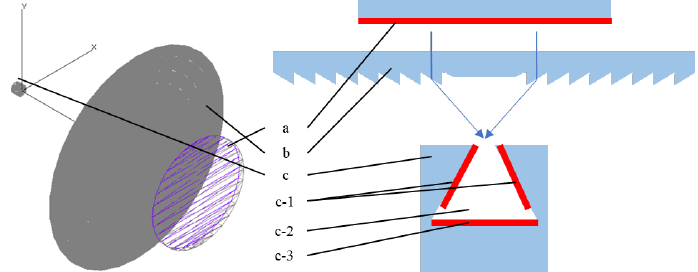
Figure 7. Ray-tracing scheme for sunlight absorption. ( a ) Sunlight source, Φ 400 mm, heat flux 1 kW, ( b ) Fresnel lens, Φ 500 mm, ( c ) cavity receiver, ( c-1 ) lateral surface for reflection, reflectivity 80%, ( c-2 ) positive conical cavity connecting to ambient air, ( c-3 ) base for absorption, diameter 154 mm, absorptance to be